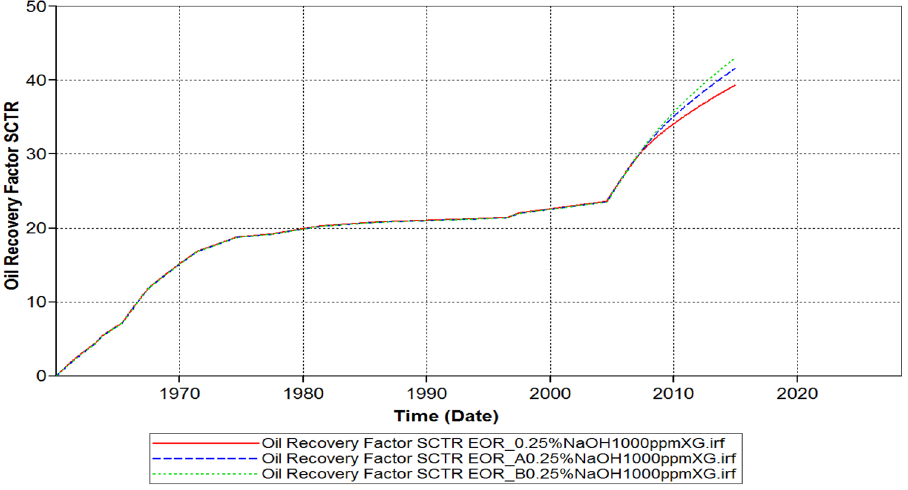
Fig. 10 Recovery factor for different injection rates (using the 0.25% NaOH 1000 ppm xanthan